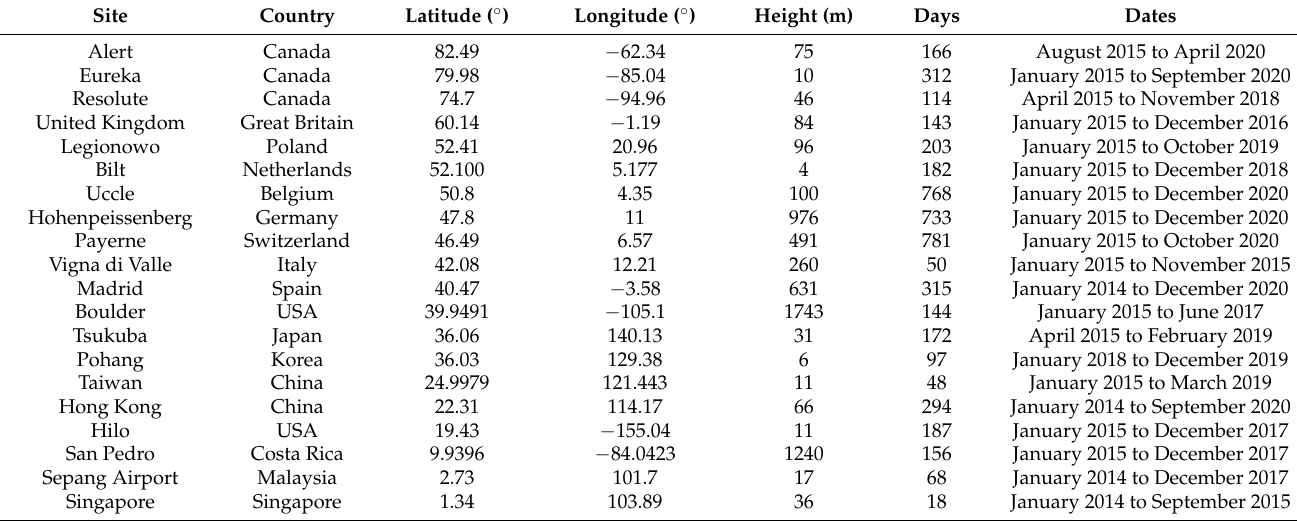
Table A1. Information of ozonesonde stations.